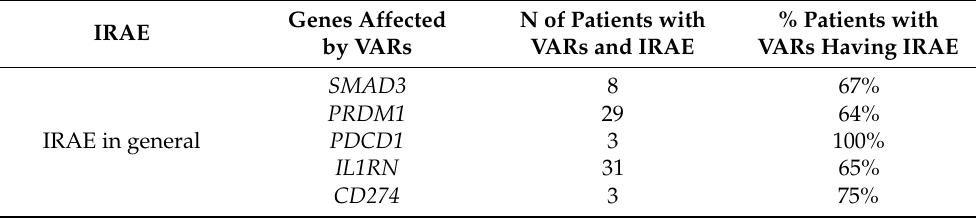
Table 6. Genes affected by VARs associated with IRAE and organ specific IRAE. Note that we only list genes with observed incidence of IRAE above the respective cohort average and concerning at least two